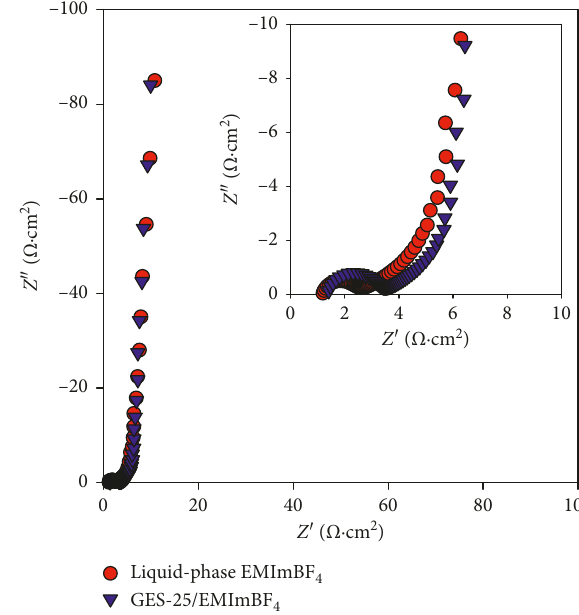
Figure 8: Nyquist plots obtained by AC impedance measurements of EDLC test cells with liquid-phase EMImBF 4 and with GES-25/ EMImBF 4 as